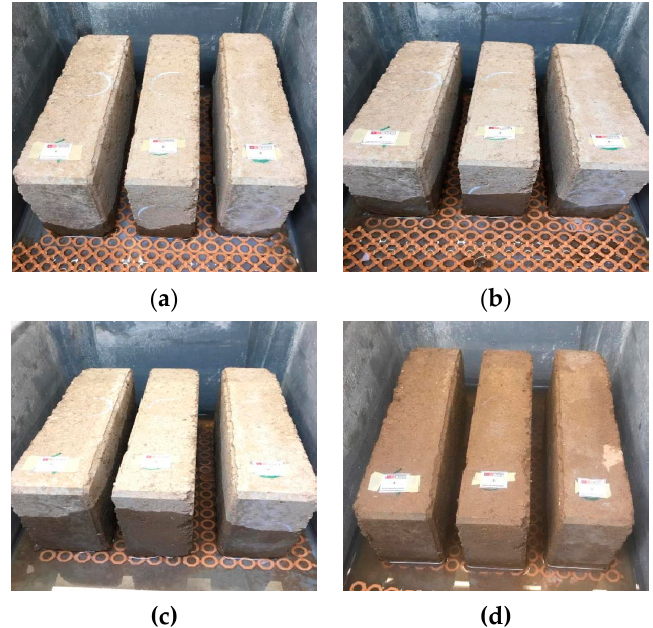
Figure 5. Water absorption by capillarity test: ( a ) after 10 min of water immersion; ( b ) after 30 min of water immersion; ( c ) after 45 min of water immersion; and ( d ) after 60 min of water immersion.